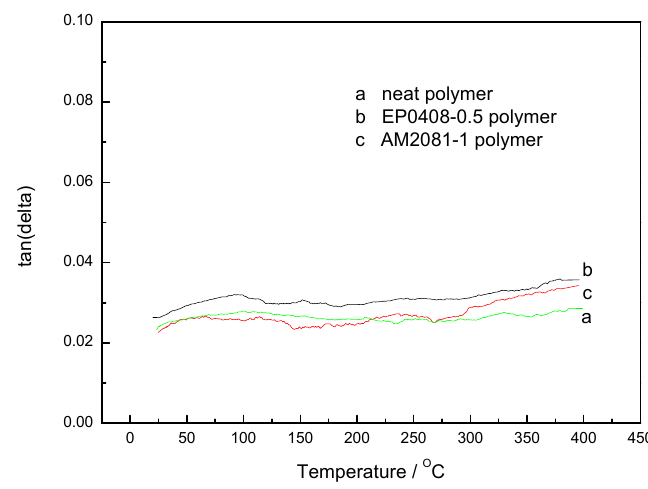
Figure 11. Damping factor (tan δ ) as a function of temperature for the neat polymer and the polymers containing AM0281 and EP0408 cured at 260 °C for 8 h, 300 °C for 8 h, and 325 °C for 8 h, and subsequently post-cured under an inert atmosphere of nitrogen at 350 °C for 8 h and 375 °C for 4 h. (a) Neat polymer, (b) EP0408-0.5 polymer, and (c) AM0281-1 polymer.